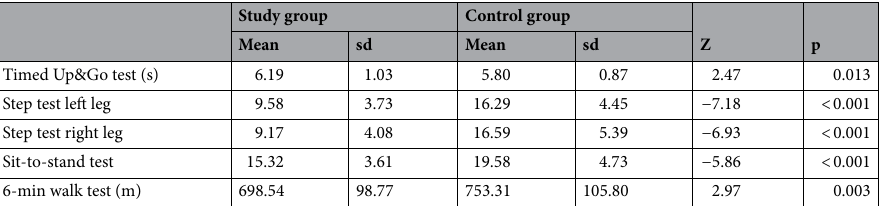
Table 4. Results of the clinical tests in study and control group. Z Mann–Whitney U-test result, sd standard deviation, p significance level, p < 0.05 reflects statistically significant relationship, p < 0.01 reflects highly significant relationship, p < 0.001 reflects very highly significant